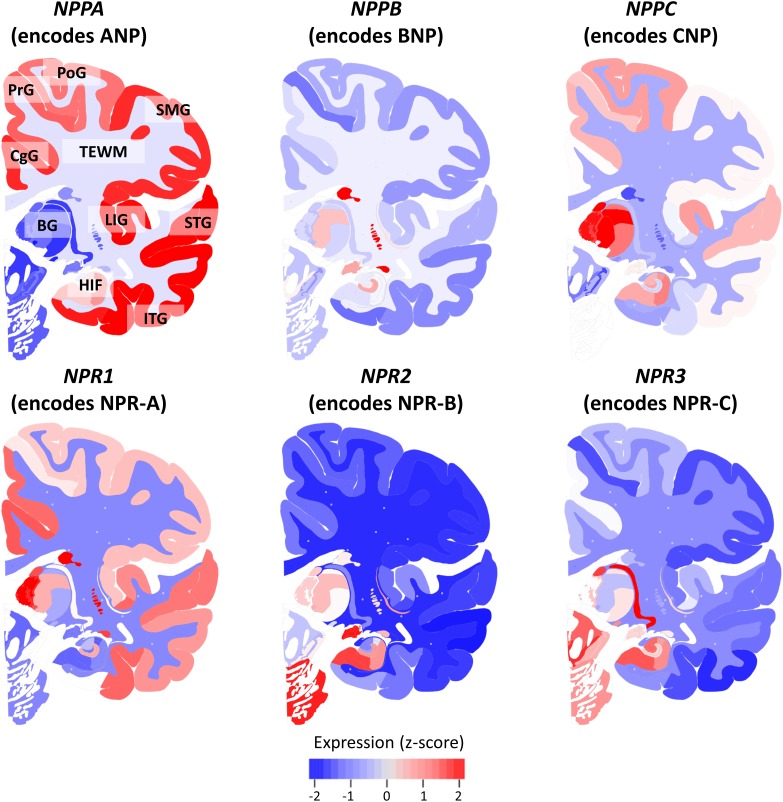
Expression of natriuretic peptides’ and natriuretic peptide receptors’ genes in the healthy human brain. The mRNA expression of genes coding for natriuretic peptides and natriuretic peptide receptors is shown in a coronal view of the left hemisphere. The Expression of each gene is z-score normalized to the average expression of the gene in the whole brain. Data from the Allen Human Brain Atlas (http://human.brain-map.org/) is visualized using the BrainScope portal (http://www.brainscope.nl/). CgG: cingulate gyrus; PrG: precentral gyrus; PoG: postcentral gyrus; SMG: supramarginal gyrus; LIG: long insular gyrus; STG: superior temporal gyrus; ITG: inferior temporal gyrus; HIF: hippocampal formation; BG: basal ganglia and TEWM: telencephalic white matter.